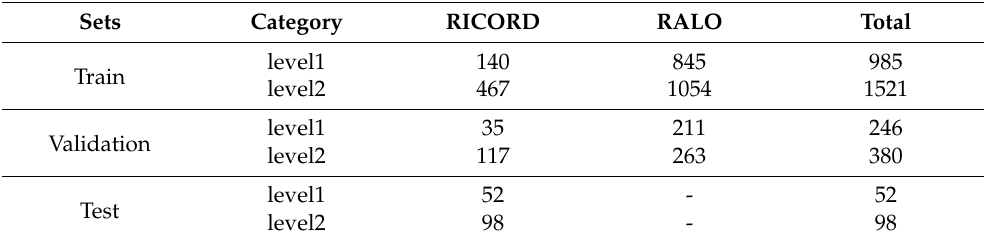
Table 2. Detailed description of the COVID-19 severity assessment dataset from the RICORD and RALO datasets.